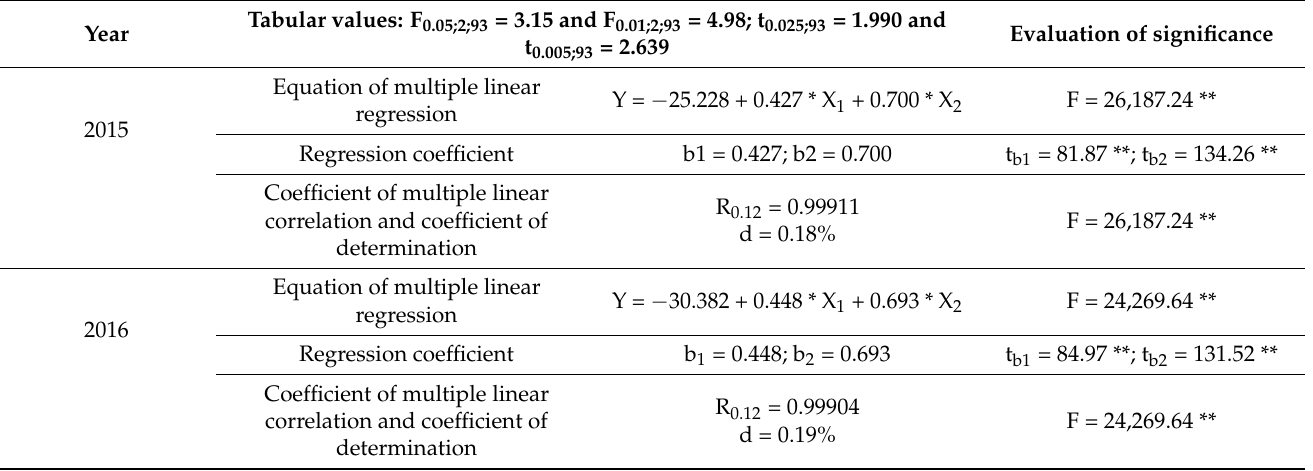
Table 7. Regression–correlation analysis of parameters